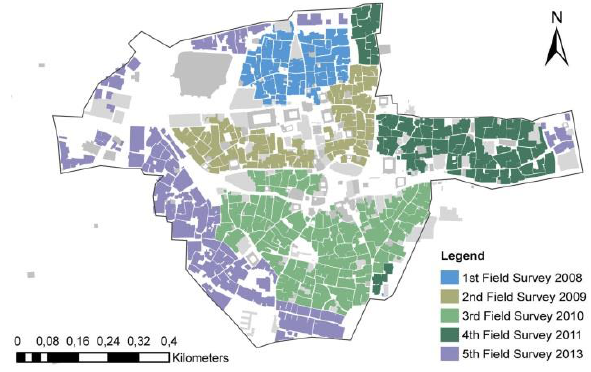
Figure 6. Survey phases in Bukhara (2008-2013). © UNESCO Field survey project (2013)